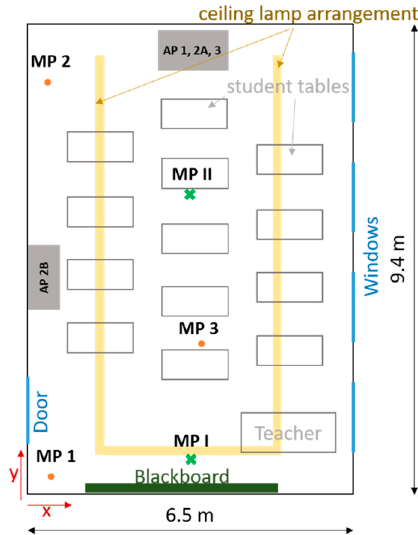
Figure 2. Sketch of a classroom with tables and locations of the APs including the positions of 5 different measuring points (MP 1, MP 2, MP 3, MP I, MP II).